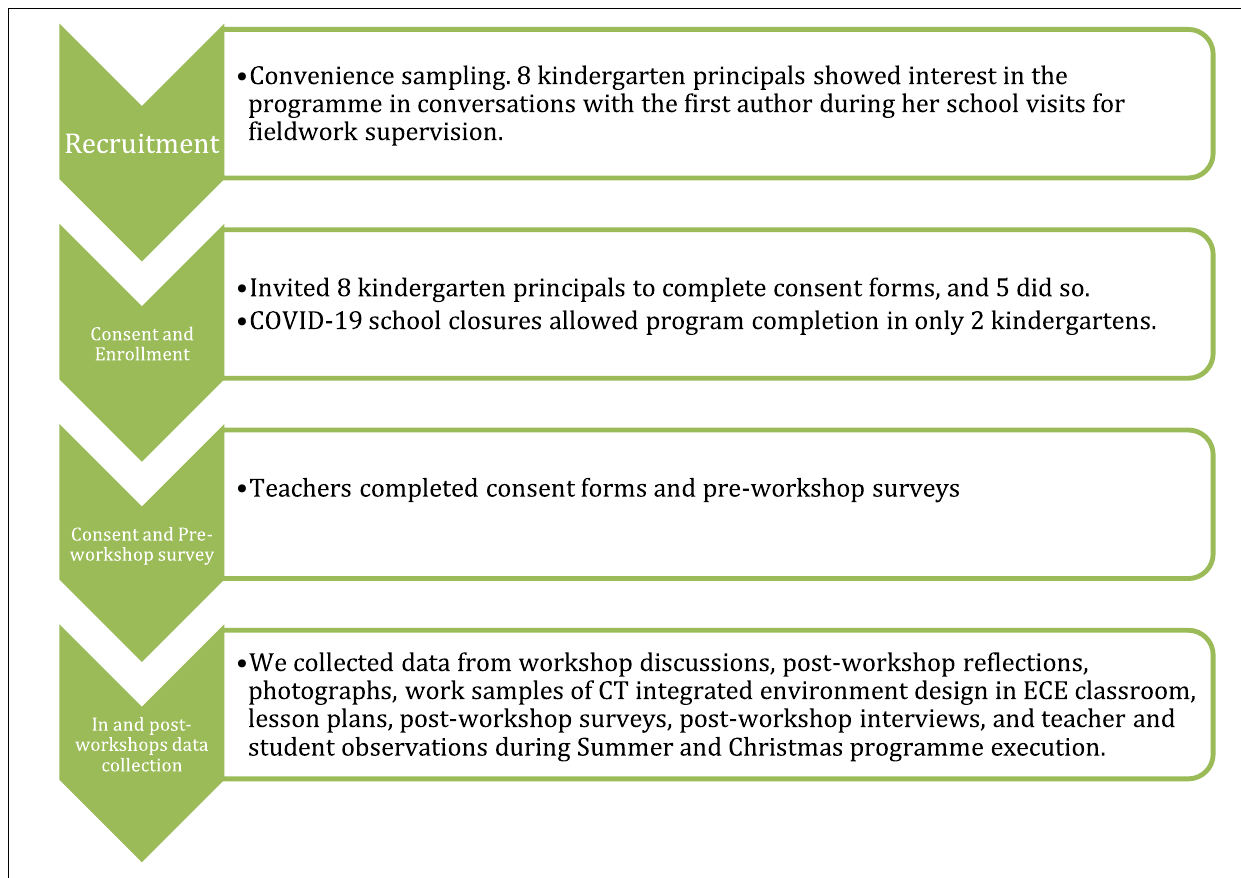
FIGURE 1 | Recruitment strategy and study